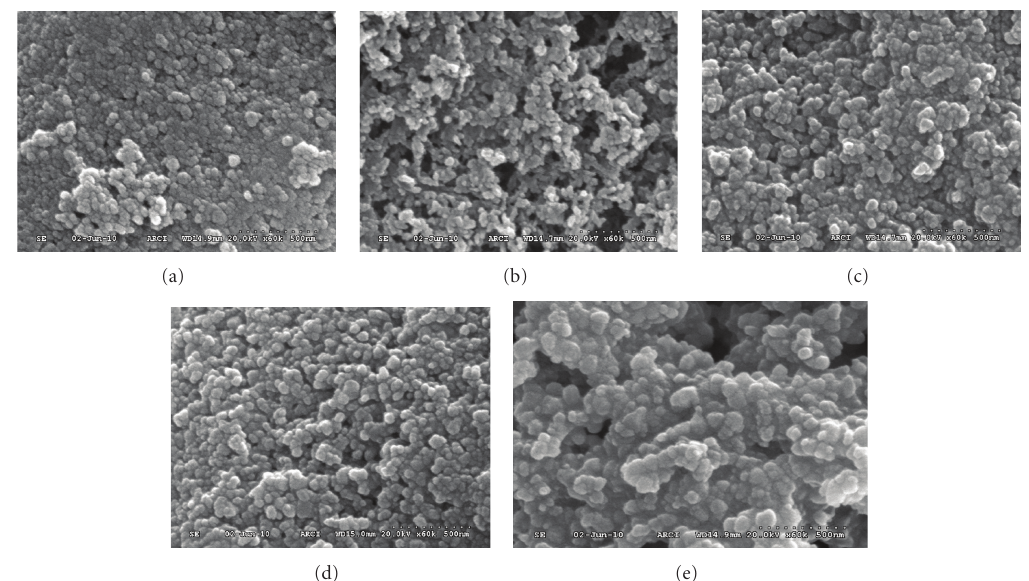
Figure 3: SEM micrographs of Ni-doped TiO 2 (Ni = 0.1 (a); 0.5 (b); 1 (c); 5 (d); 10 (e) at. wt.%) powders formed at 550 ◦ C for 6h.